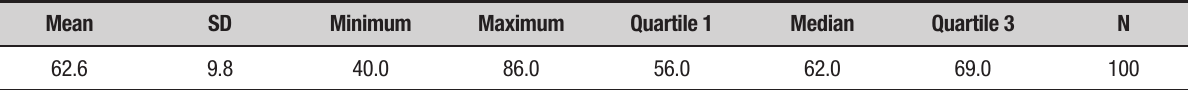
Table 2. Age range.